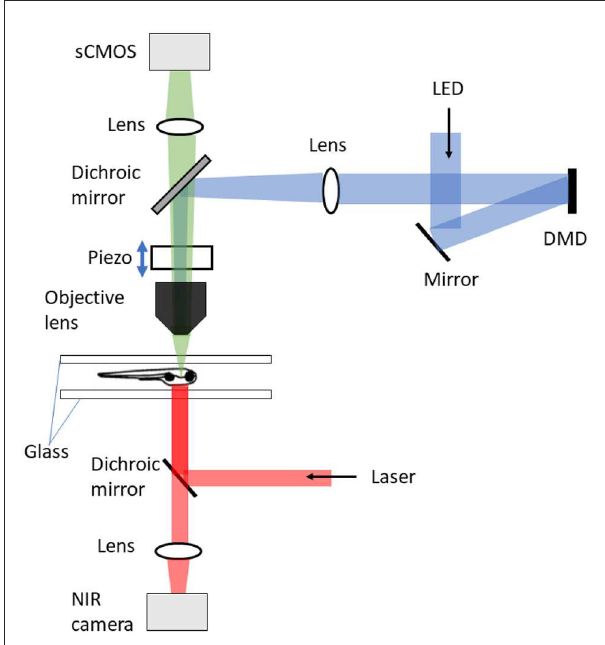
FIGURE2 DIFF setup with tracking microscopy (Kim et al., 2017). The tracking microscope consists of three major components: DIFF imaging system, motion cancelation, and stimulus delivery. The DIFF imaging system is illuminated by an LED light source. After passing through the tapered glass homogenizer and magnified by a 4f relay (not shown), the light reflects off a fold mirror and illuminates a digital micro-mirror (DMD) device. The DMD ace is imaged to the focal plane of the objective lens. In the fluorescence detection path, the sample is imaged to a global shutter sCMOS camera after passing through the objective lens, a dichroic mirror and an imaging lens. The motion cancelation system includes a high speed motorized xy stage (not shown), an objective-coupled piezo z stage, a behavioral arena and an infrared imaging system for tracking fish position and heading. The infrared system is also used to generate thermal